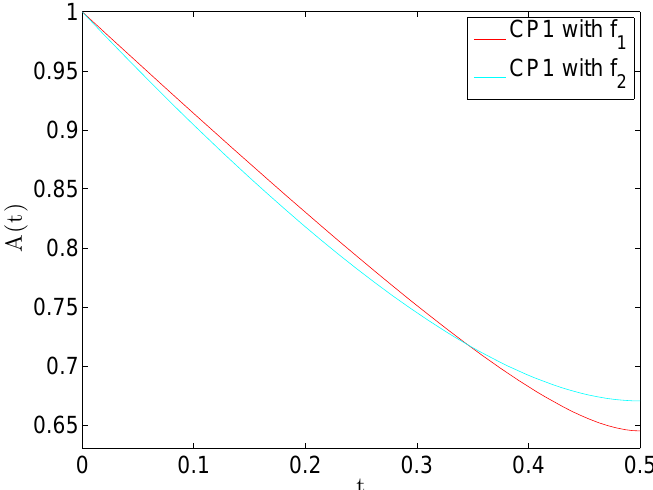
Figure 2: The bivariate Pickands dependence functions for the same Ψ H corresponding to the CP1 case, where the approach using f 1 (Example 2) is compared to the result for f 2 (Example 3). The parameters are chosen such that both models exhibit a Spearman’s ρ of 0.75